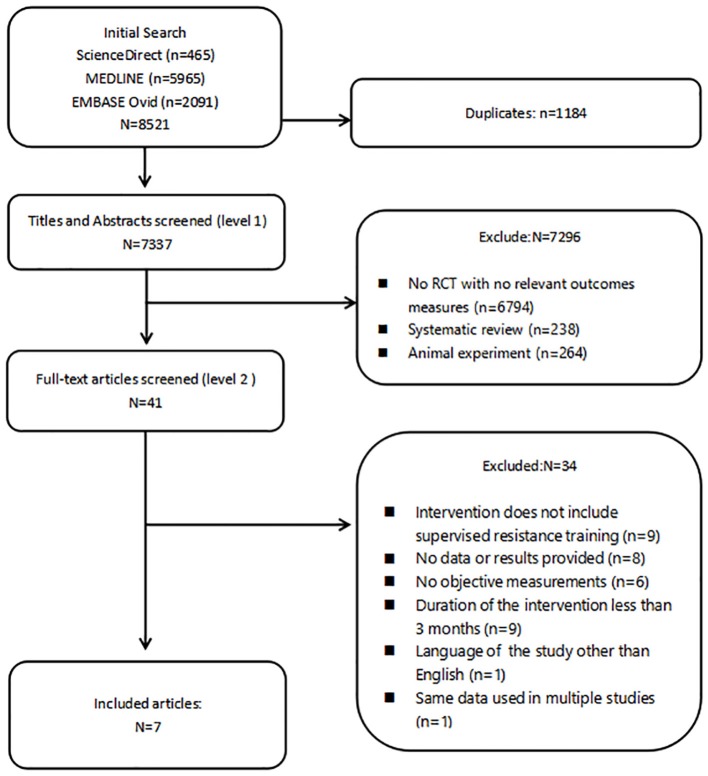
Screening chart.